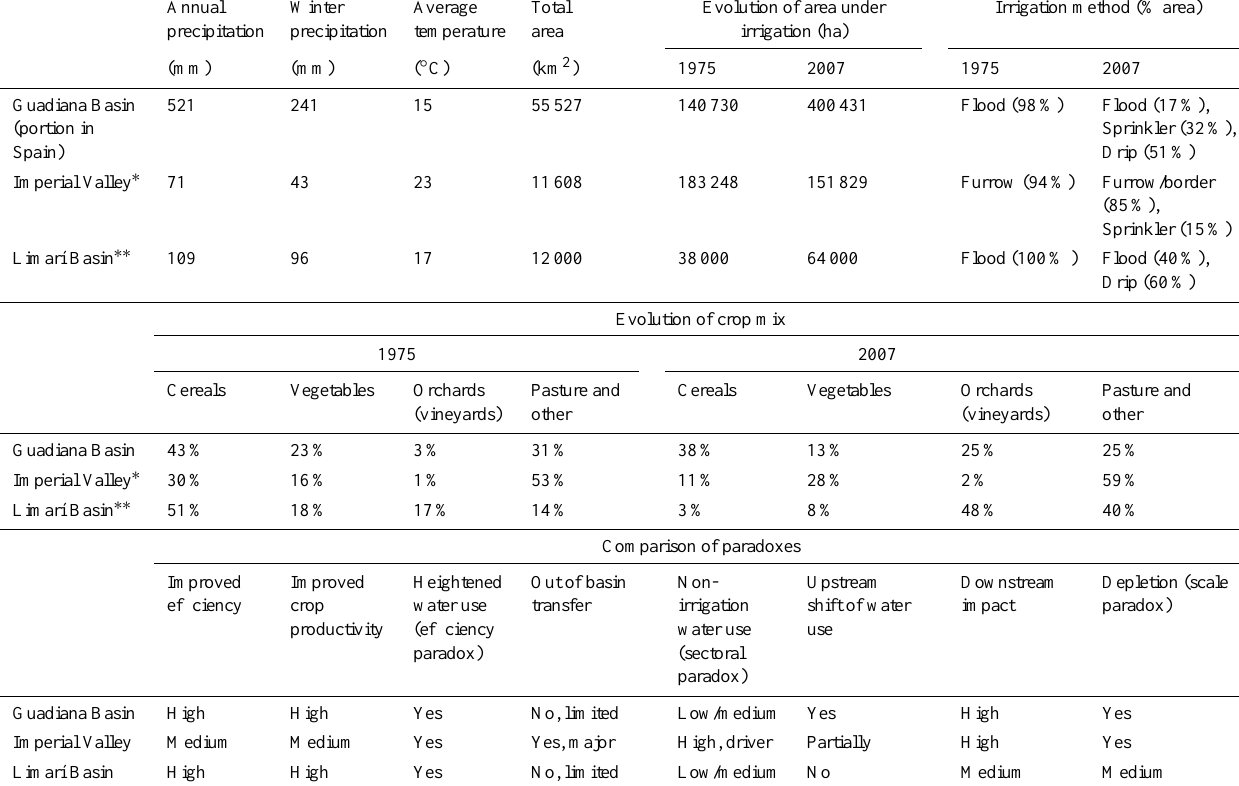
Table 1. Basin socio-hydrological